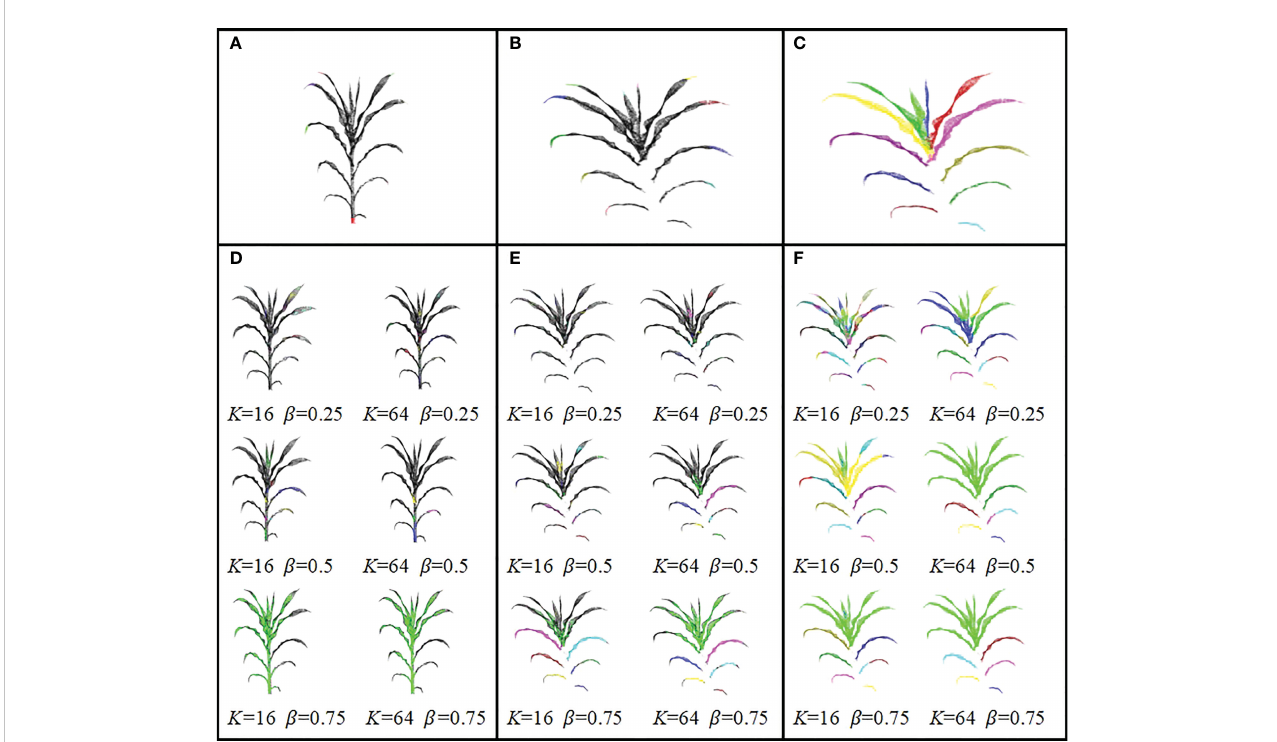
FIGURE 6 Visualization differences between DFSP and Quickshift++ for organ terminal region extraction and leaf segmentation. The same K and b parameters are used with DFSP and Quickshift++. (A) Organ terminal region extraction using DFSP; (B) Leaf tip region extraction using DFSP; (C) Leaf segmentation using DFSP. (D) Organ end region extraction directly with Quickshift++ under multiple sets of parameters. (E) Leaf tip region extraction directly with Quickshift++ under multiple sets of parameters. (F) Leaf segmentation directly with Quickshift++ under multiple sets of